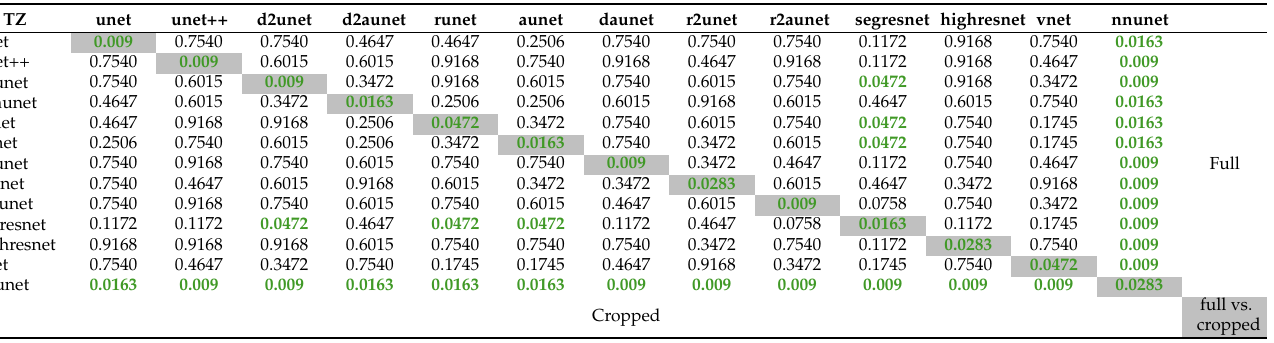
Table A2. p -values using Kruskal–Wallis for the dice scores obtained in the cross-validation of the transition segmentation task. On the top area we compare the performance of the different architectures on the full data, and on the bottom on the cropped data. On the diagonal we present the comparison of the same architecture on both data types. Significant values ( p < 0.05) are highlighted in green.